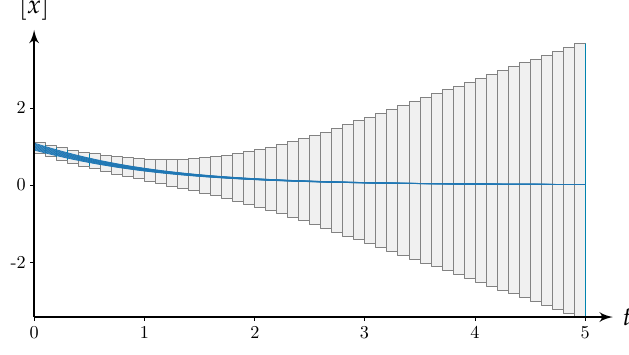
Figure 11. Differential constraint ˙ x = − sin ( x ) applied using C Picard